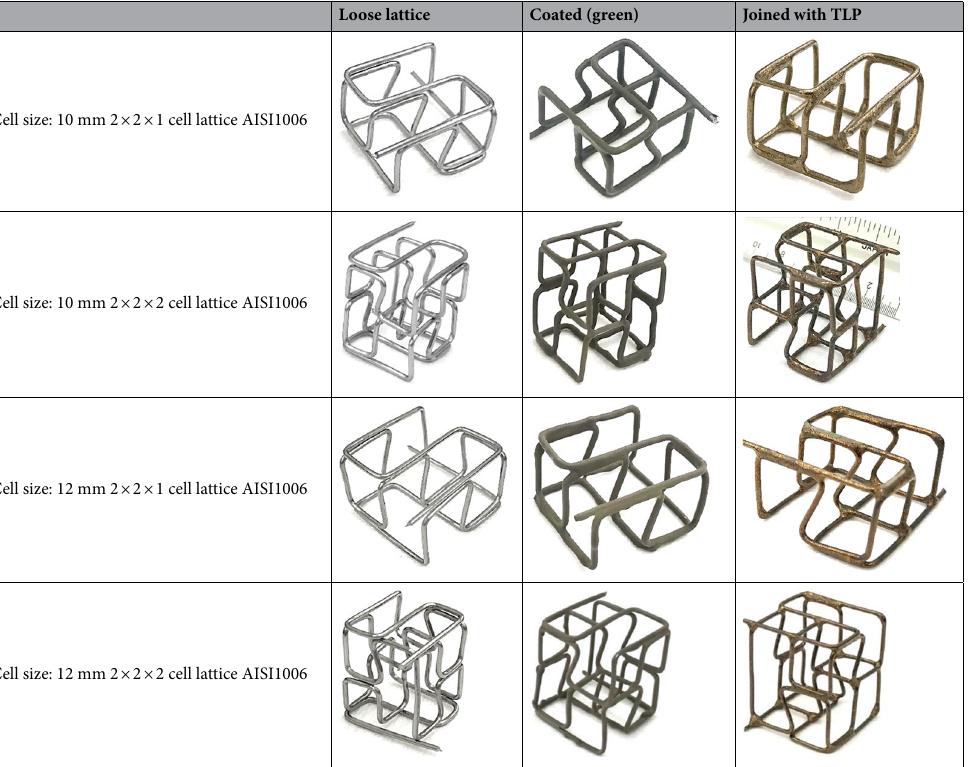
Loose lattice Coated (green) Joined with